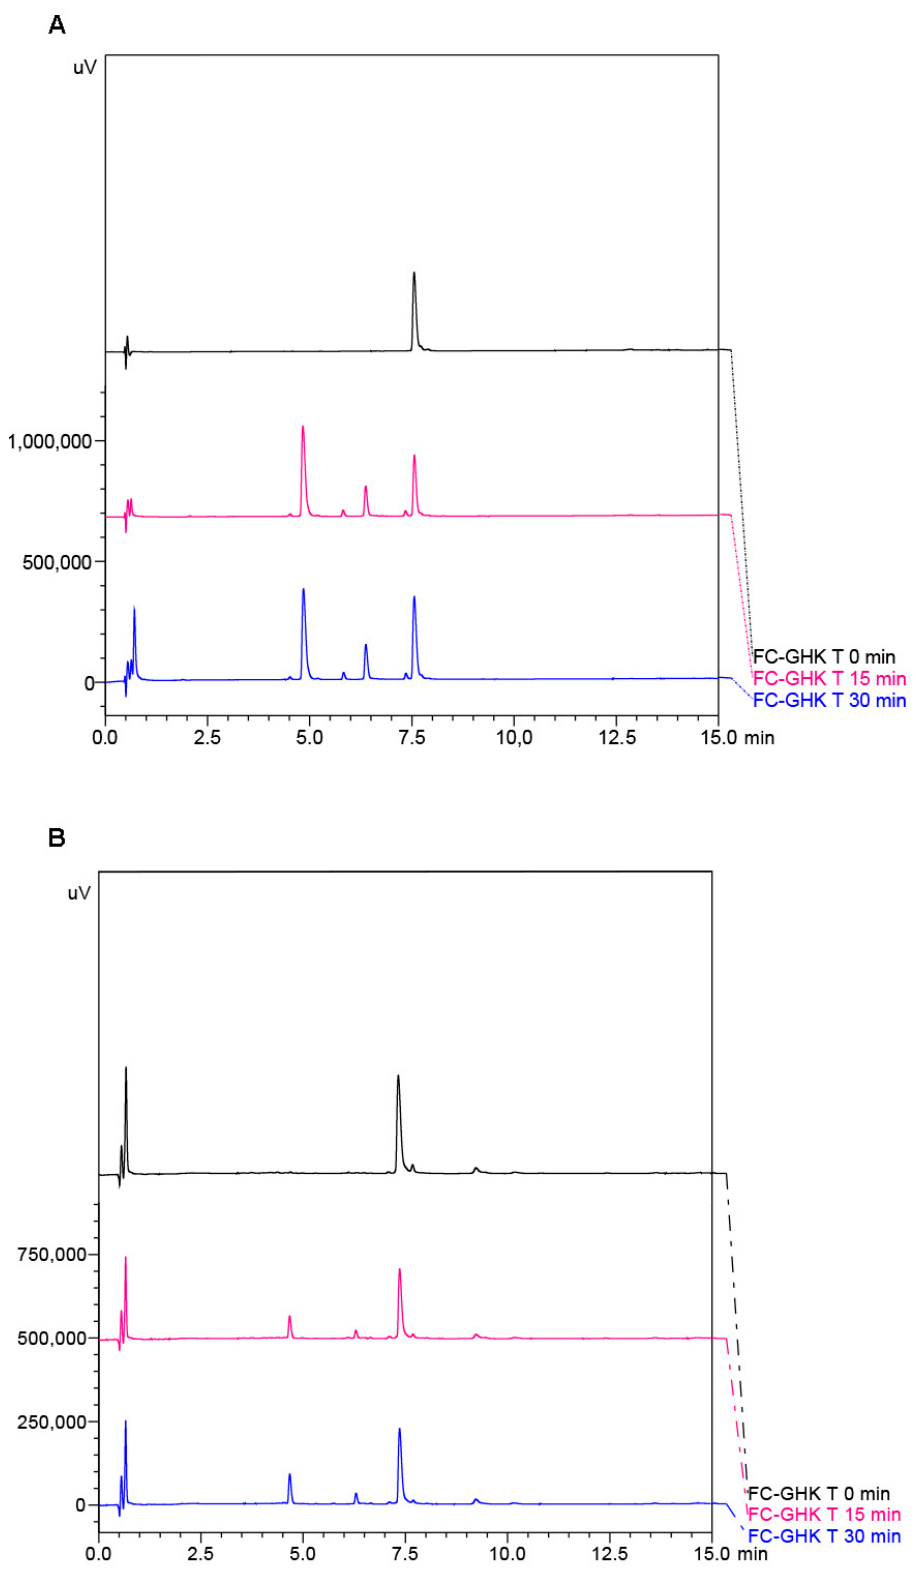
Figure 6. Chromatograms for ( A ) non-fibrillated FC-GHK and ( B ) FC-GHK as the fibril form, after neutrophil elastase digestion at the start (black line), after 15 min (pink line) and after 30 min (blue line) of incubation with the enzyme.